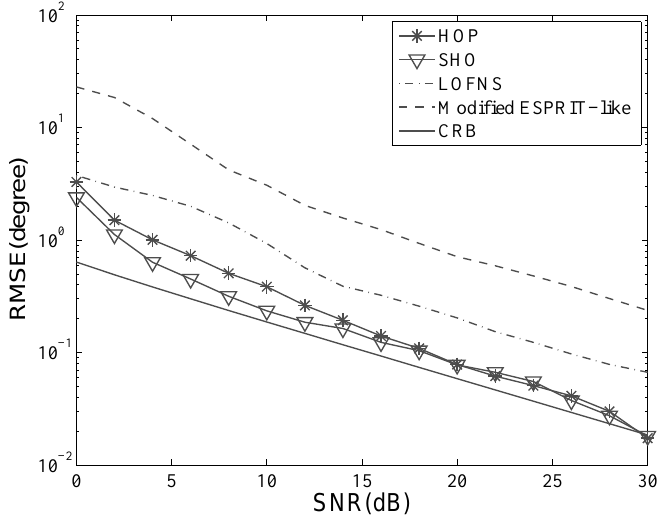
Figure 4. RMSE versus SNR: DOA of the first source.